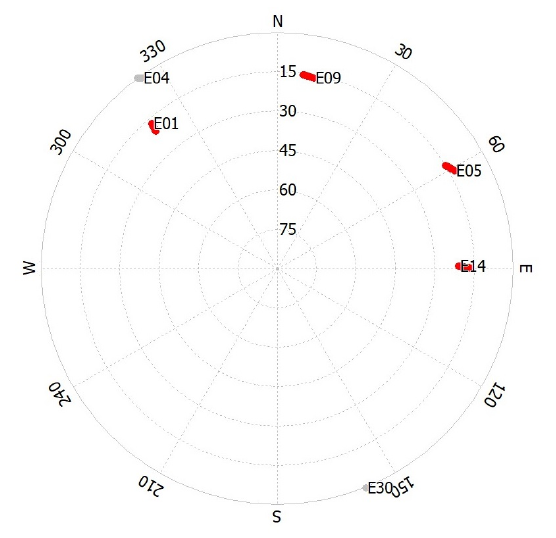
Figure 7. Galileo system skyplot in the YEL2 site on DOY 55 from 4:40–5:00